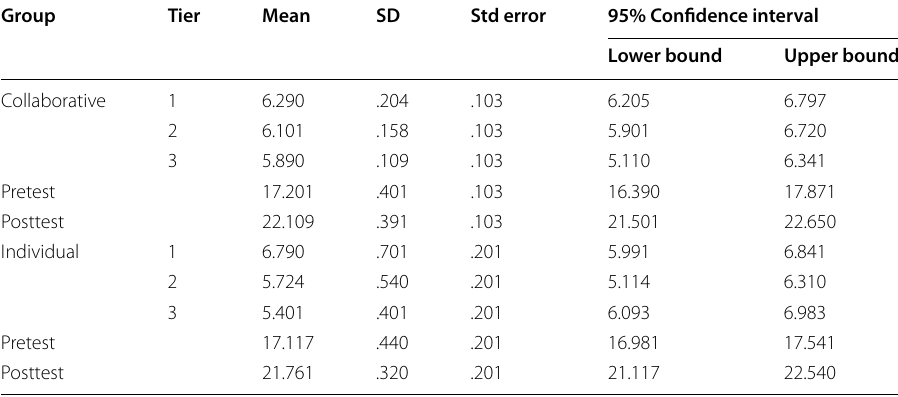
Lower bound Upper bound